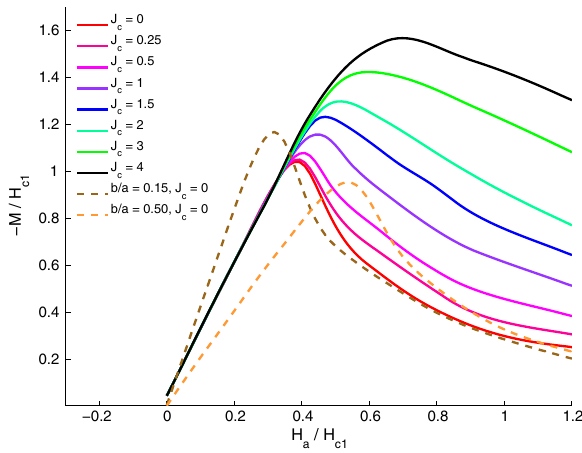
FIG. 10. Magnetization curves for a disk sample with different pinning and geometry. Solid lines correspond to the sample with b = a ¼ 0 . 3 while the dash line correspond to pin-free sample with b = a ¼ 0 . 15 and 0.50. The critical current density J of the pinning strength. The larger J Adapted from